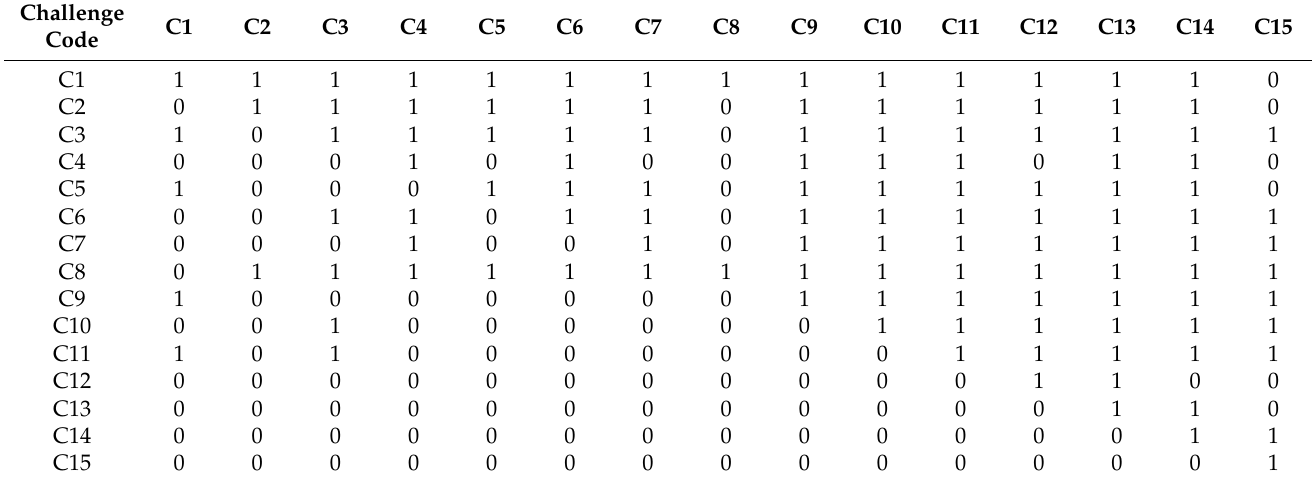
Table 5. Initial reachability matrix.